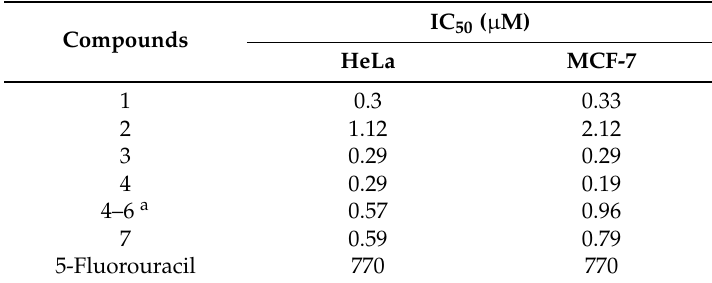
Table 2. Cytotoxicities of compounds 1 – 7 against HeLa and MCF-7